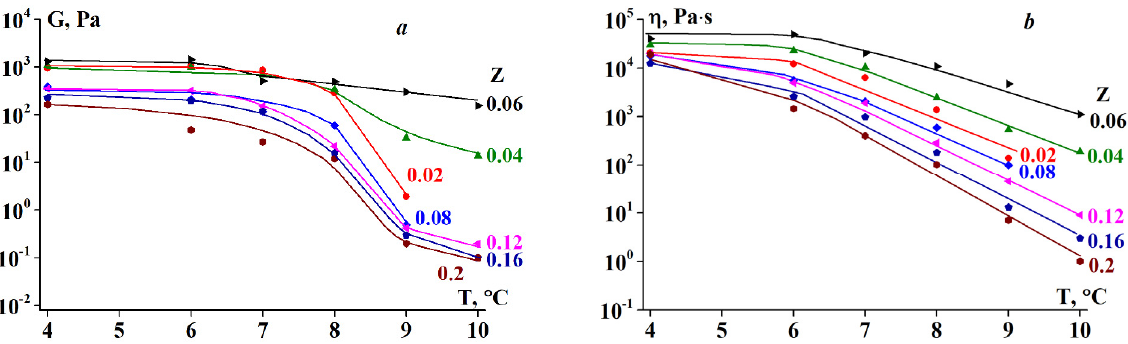
Figure 10. ( a ) Elastic modulus and ( b ) shear viscosity dependency on temperature at σ = 5 Pa. Z values are shown on the